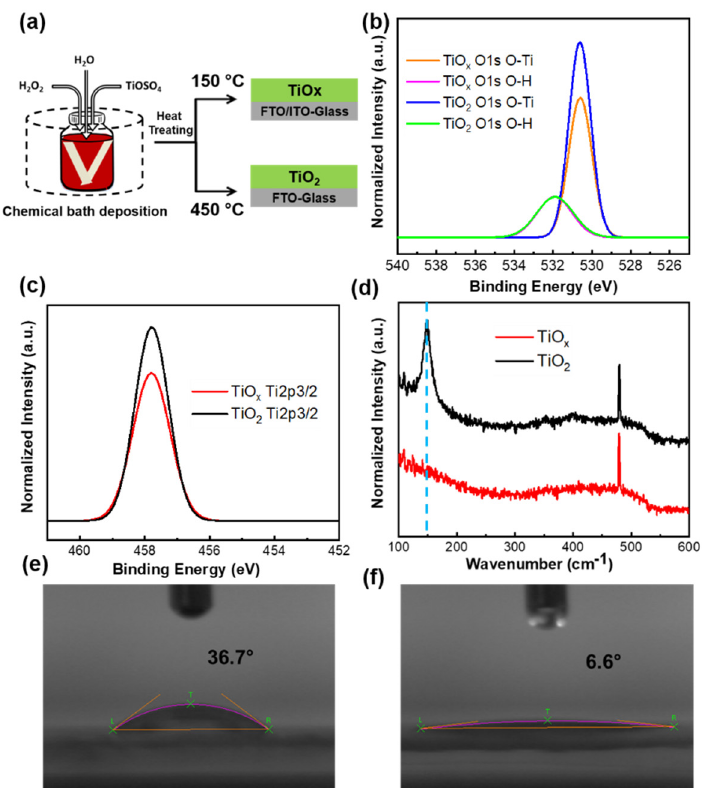
Figure 1. ( a ) Schematic illustration of the chemical bath deposited titanium dioxide (TiOx) films, as well as their corresponding thermal treatments at 150 °C for 1 h and 450 °C for 30 min; XPS spectra of TiO x and titanium oxide (TiO 2 ), ( b ) O1s, and ( c ) Ti2p; ( d ) Raman spectra of TiO x and TiO 2 films; and water contact angles of the ( e ) TiO x and ( f ) TiO 2 films on an FTO substrate.